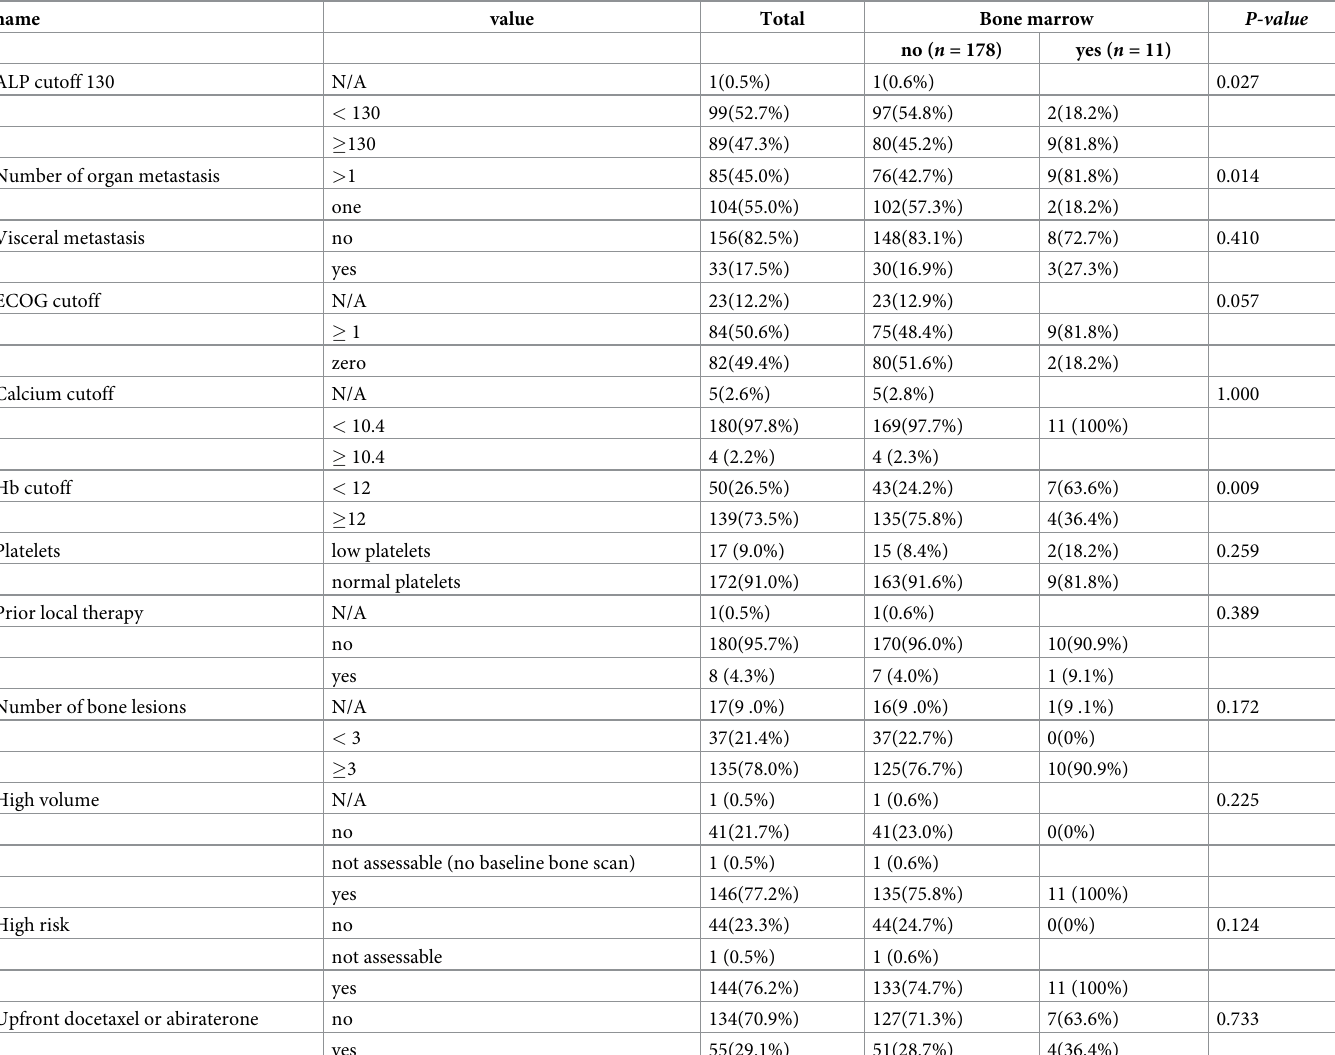
Table 1. Characteristics of patients with metastatic castrate sensitive prostate cancer with bone marrow involvement and without bone marrow